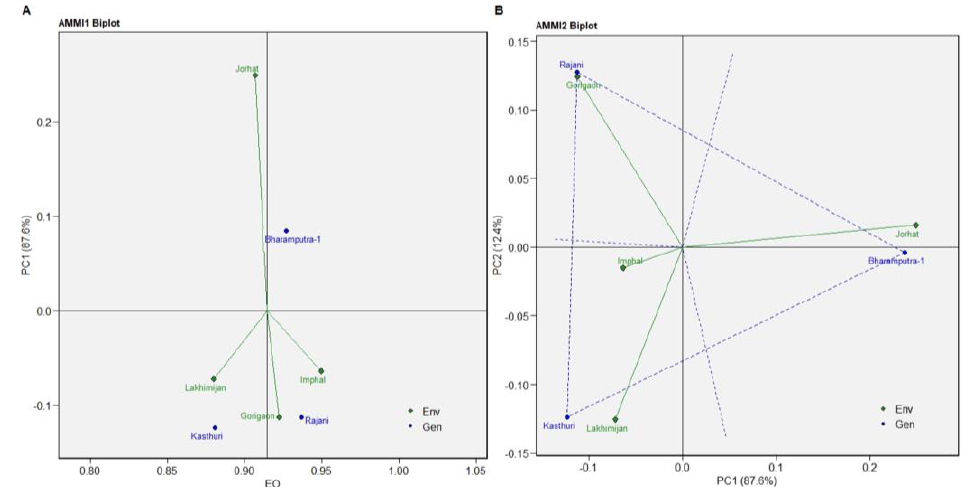
Figure 6. ( A ) AMMI1 biplot ( B ) AMMI2 for essential oil yield. The date of maturity was earlier for Bharamputra-1, followed by Kasthuri and Rajani, as revealed by the AMMI1 biplot (Figure 7A). Bharamputra-1 was indicated as the genotype suitable for Lakhimijan and Gorigaon locations, while Kasthuri and Rajani was favourable for Imphal and Jorhat, respectively (Figure 7B). Both the Eberhart–Russel and the AMMI model analyses clearly demonstrated Bharamputra-1 as a superior stable genotype based on rhizome yield and essential oil yield.